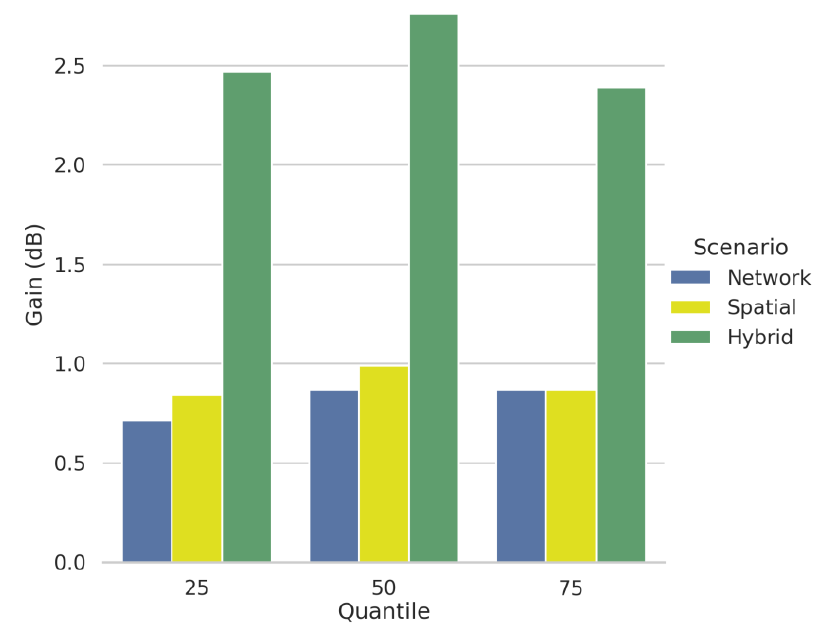
Figure 11. Comparison between the different algorithms ’ improvement vs. the baseline for SINR gain (dB).